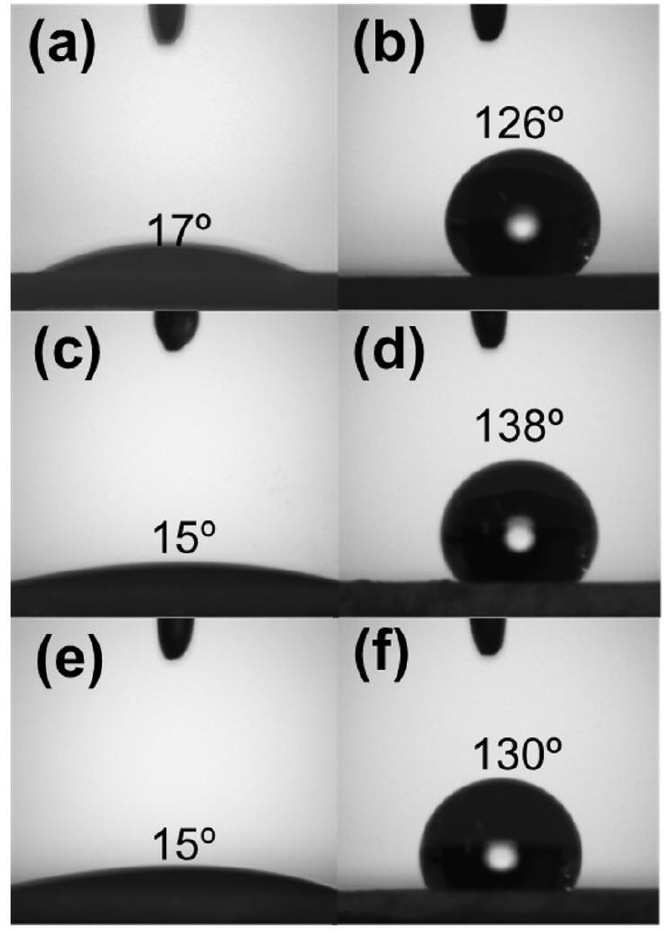
Figure 4. The contact angle for unmodified (left) and modified (right) SiO 2 surface: ( a , b ) AC, ( c , d ) SG, and ( e , f ) RH.